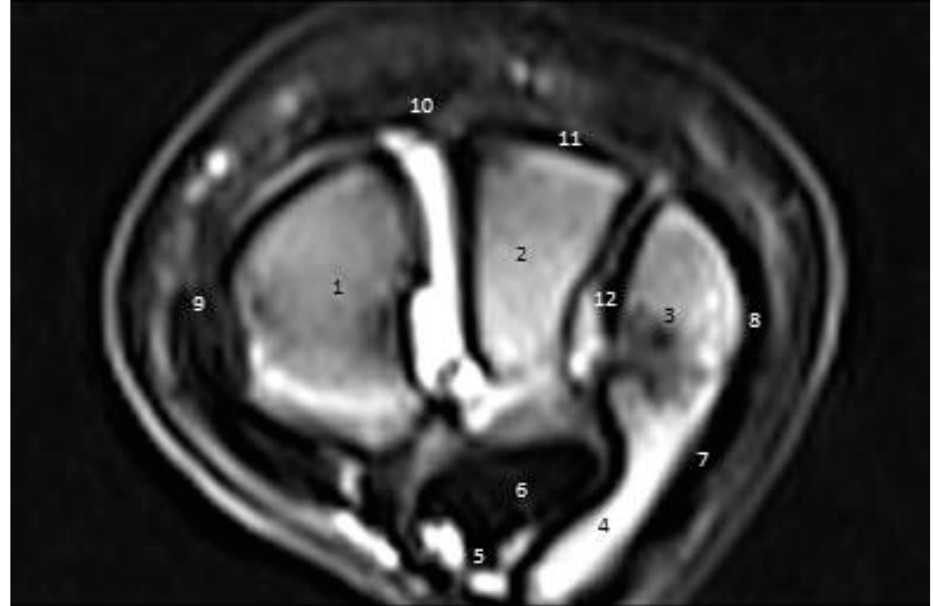
Figure 8. A cross-sectional magnetic resonance imaging scan of the carpal joint in donkeys at the level of the first row of carpal bones. (1) Radiocarpal bone. (2) Intermediate carpal bone. (3) Ulnar carpal bone. (4) Accessory carpal bone. (5) Superficial digital flexor. (6) Deep digital flexor. (7) Ulnaris lateralis tendon. (8) Lateral collateral ligament. (9) Medial collateral ligament. (10) Extensor carpi radialis tendon. (11) Common digital extensor. (12) Transverse intercarpal ligament.